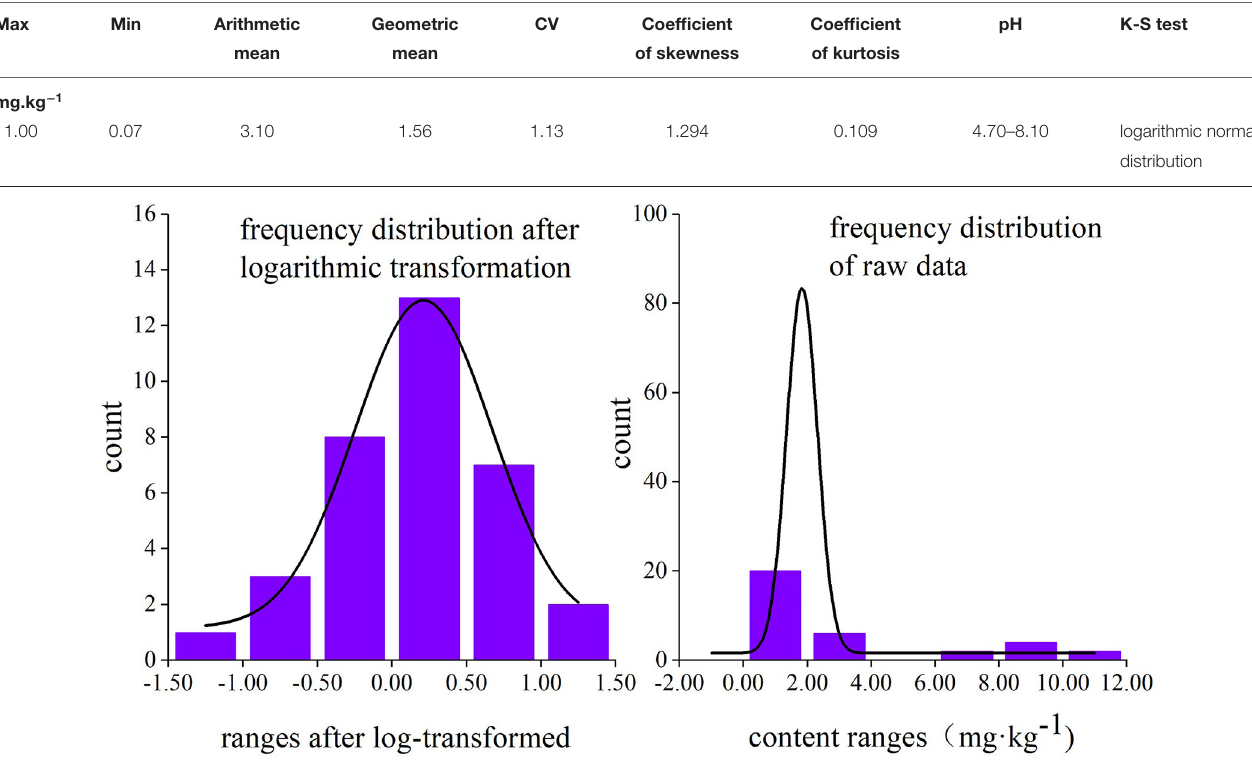
TABLE 1 | Concentrations of antimony (Sb) on the surface layer of paddy soil.